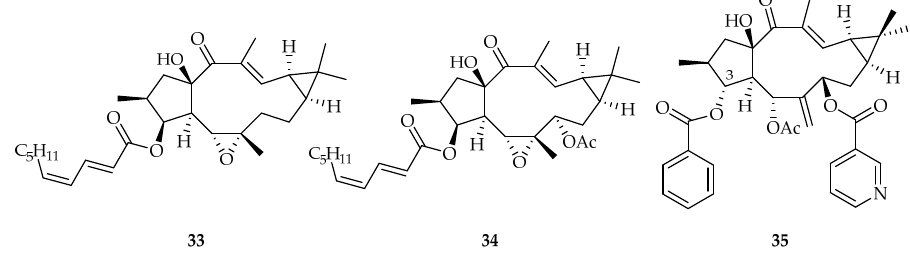
Figure 14. Structures of euphstrachenols A 33 [19] and B 34 [19] and euphorbia factor L 28 35 [25].